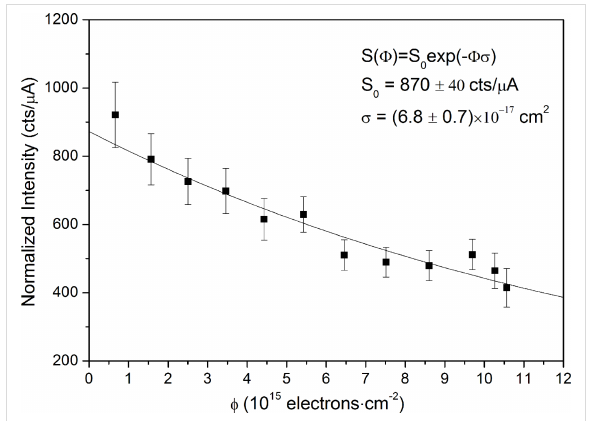
Figure 4: Evolution of CF 3 neutral fragment detection with the cumu- lated dose (fluence) under irradiation at 1.5 eV. Squares: measure- ment, line: adjusted